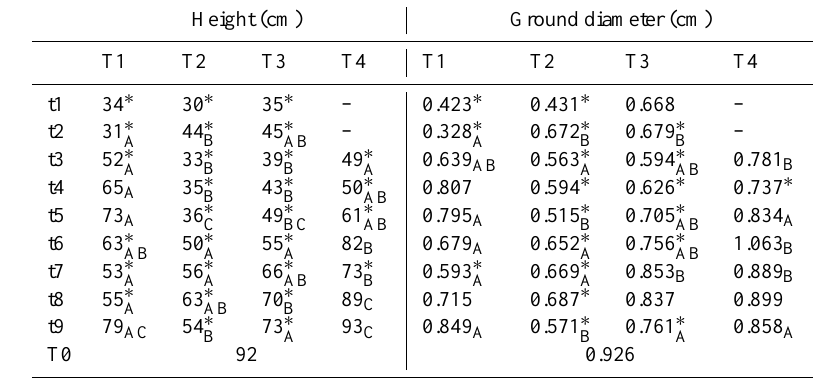
Table 4. Average height and ground diameter of A. fruticosa